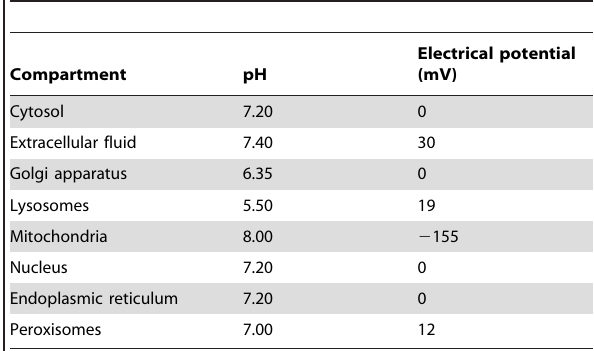
Table 2. pH and electrical potential in each compartment of the human reconstruction Recon